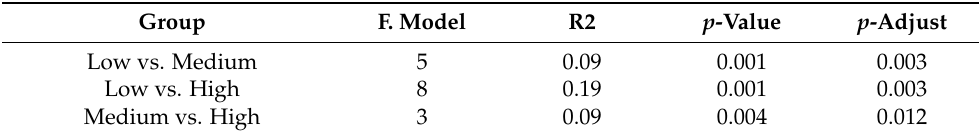
Table 1. ADONIS test between each of the two sample groups.